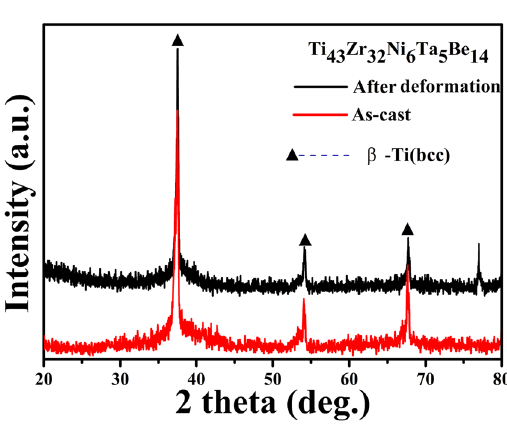
Figure 4. XRD patterns of the present Ti-based MGMCs before and after